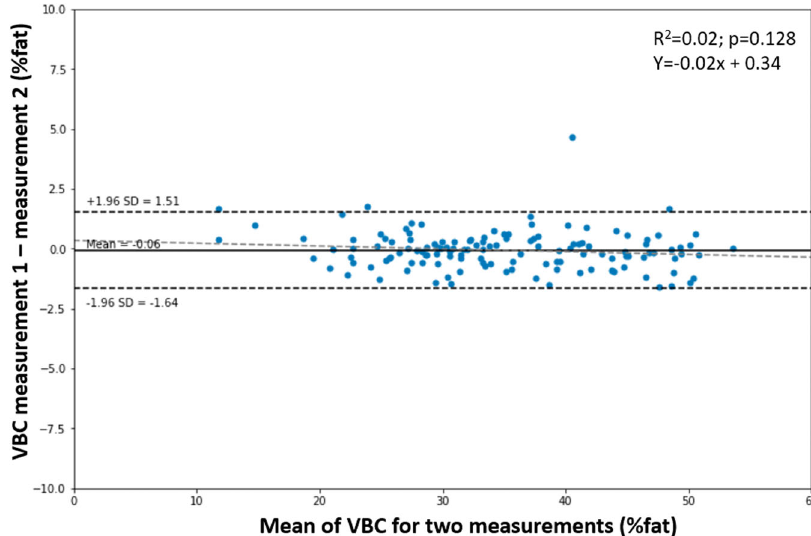
Fig. 5 Bland-Altman analysis of repeated VBC measurements to assess technical error.